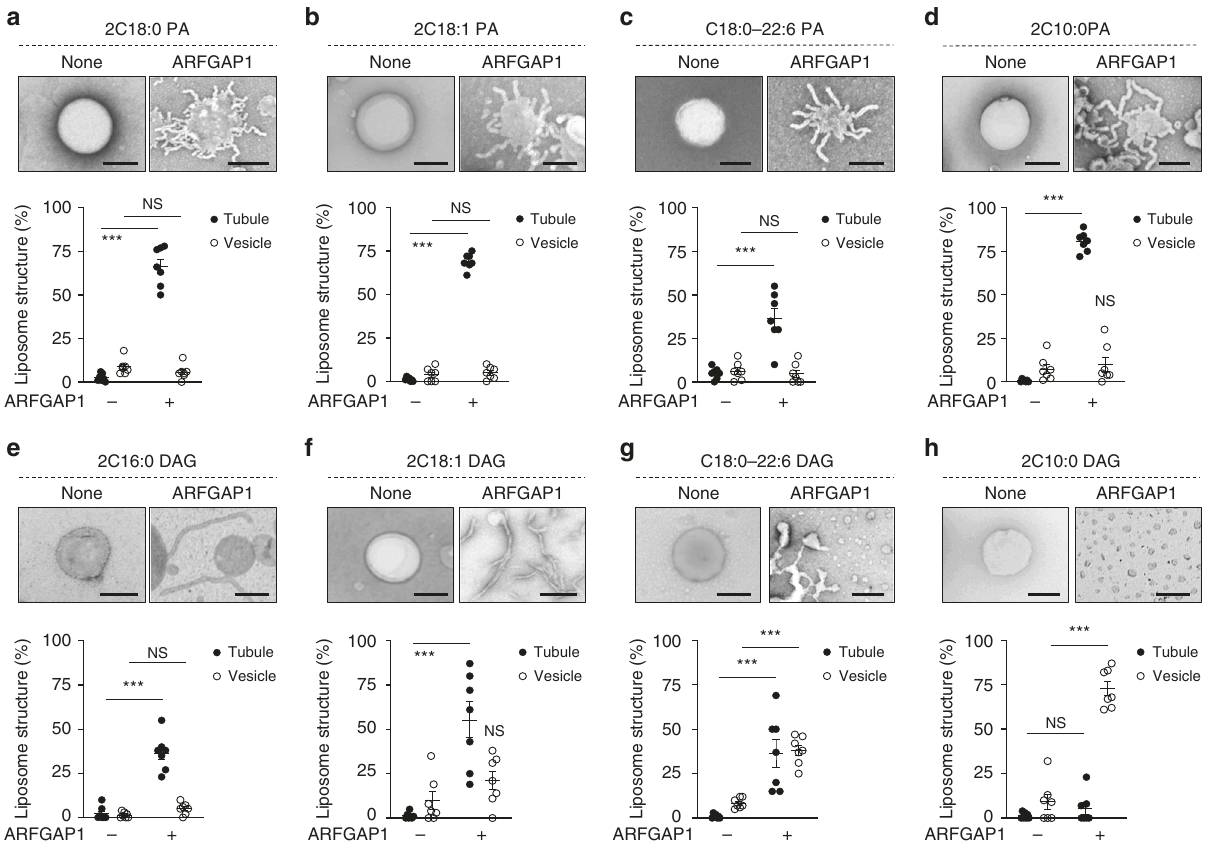
Fig. 8 Short diacylglycerol (DAG) promotes vesiculation by ARFGAP1. Quantitative data are shown as mean ± s.e.m. Signi fi cance was tested using the two- tailed Student ’ s t test, *** P < 0.0001, NS P > 0.05. a – d Liposomes with different forms of phosphatidic acid as indicated were incubated with recombinant ARFGAP1 and then examined by electron microscopy (EM). Representative images are shown above, bar = 250nm. Quantitation of liposome tubulation and vesiculation is shown below; n = 4 independent experiments. e – h Liposomes with different forms of DAG as indicated were incubated with recombinant ARFGAP1 and then examined by EM. Representative images are shown above, bar = 250nm. Quantitation of liposome tubulation and vesiculation is shown below; n = 4 independent experiments. Source data are provided as a Source Data fi